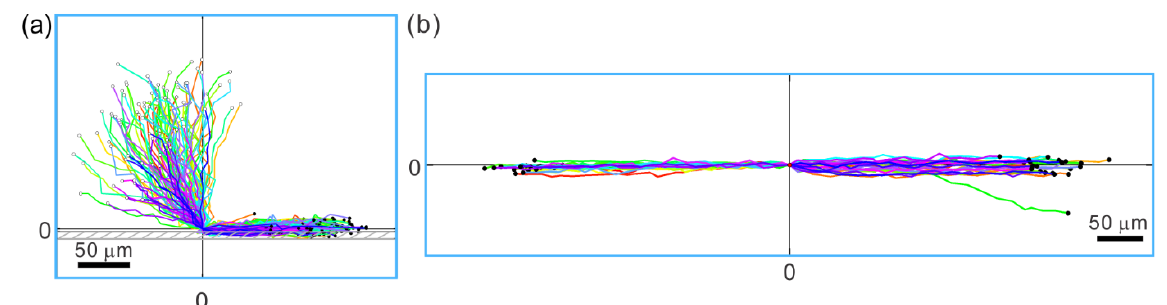
Figure 4. Tracks of sperm interactions with solid structures, as seen looking down from above. ( a ) Sperm that approach a sidewall from all angles (starting points denoted with open dots) swim along the sidewall (end points denoted with filled black dots) after hitting the wall. The location of wall contact is adjusted to (0,0) for each trajectory. ( b ) When sperm encounter a microgroove structure, the overwhelming majority of them remain in the groove. The starting points of the tracks are adjusted to (0,0). End points of the sperm trajectories are indicated by black dots. Note that sperm swim in either direction from the point of entry into the microgroove. Only one out of 50 sperm swam out of the microgroove. Adapted from Ref. [53]. Copyright 2015 by the authors.